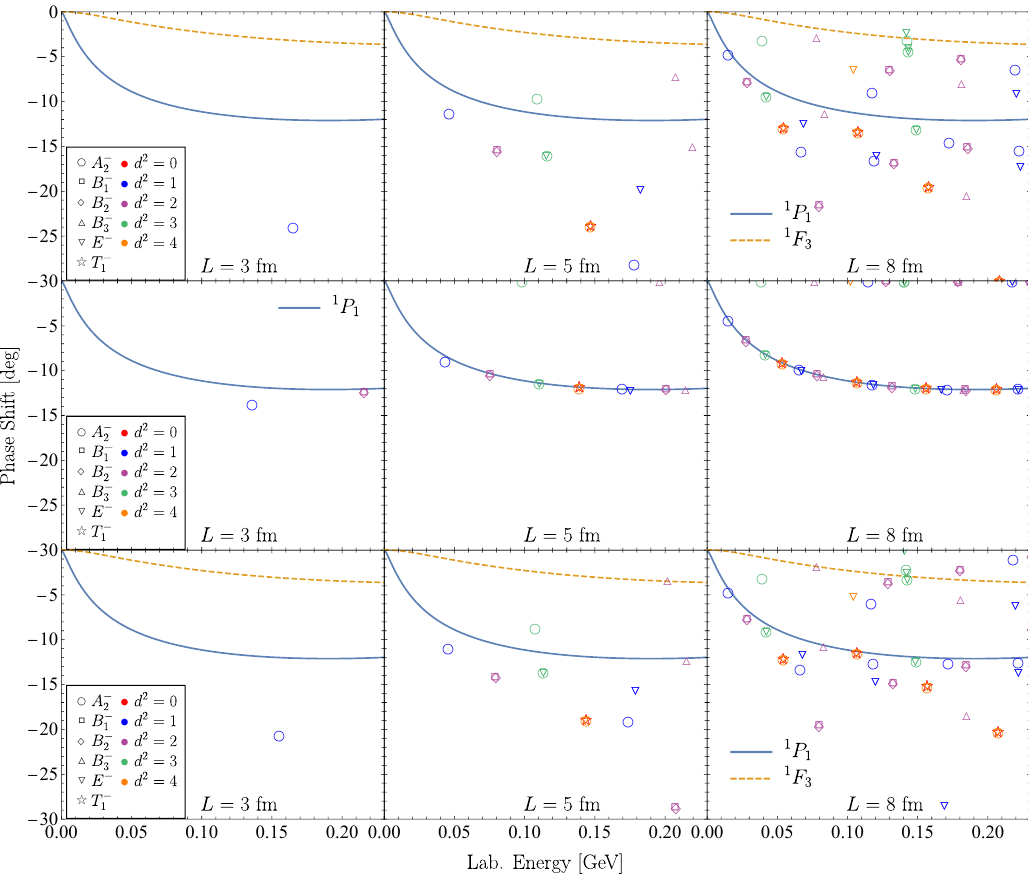
Figure 6 . Phase shifts in the negative-parity channels extracted from the FV energy spectra using the P-wave Lüscher formula (various symbols) in comparison with the infinite-volume results for the OPE potential (upper row), the P-wave projected OPE potential (middle row) and the P- and F-wave projected OPE potential. Solid and dashed lines show the 1 P 1 and 1 F 3 phase shifts calculated in the infinite volume. For remaining notations see figure